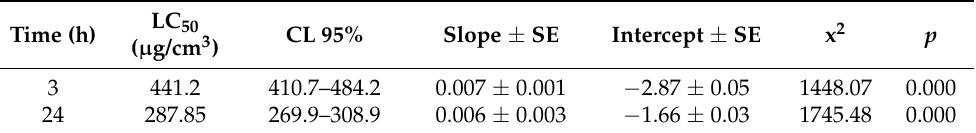
Table 2. Larvicidal activity of PLF He recorded at 3 and 24 h after Petri dish residual exposure bioassay. LC 50 values are considered significantly different when 95% CL fail to overlap. Since goodness-of-fit test is significant ( p < 0.05), a heterogeneity factor is used in the calculation of confidence limits (CL). LC 50 CL 95% Time (h) ( µ g/cm 3 )